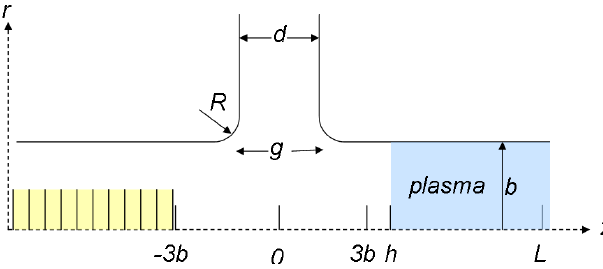
FIG. 9. (Color) Schematic of the incoming beam, drift tube, IBM gap, and plasma geometry used in the semianalytic opti- mization